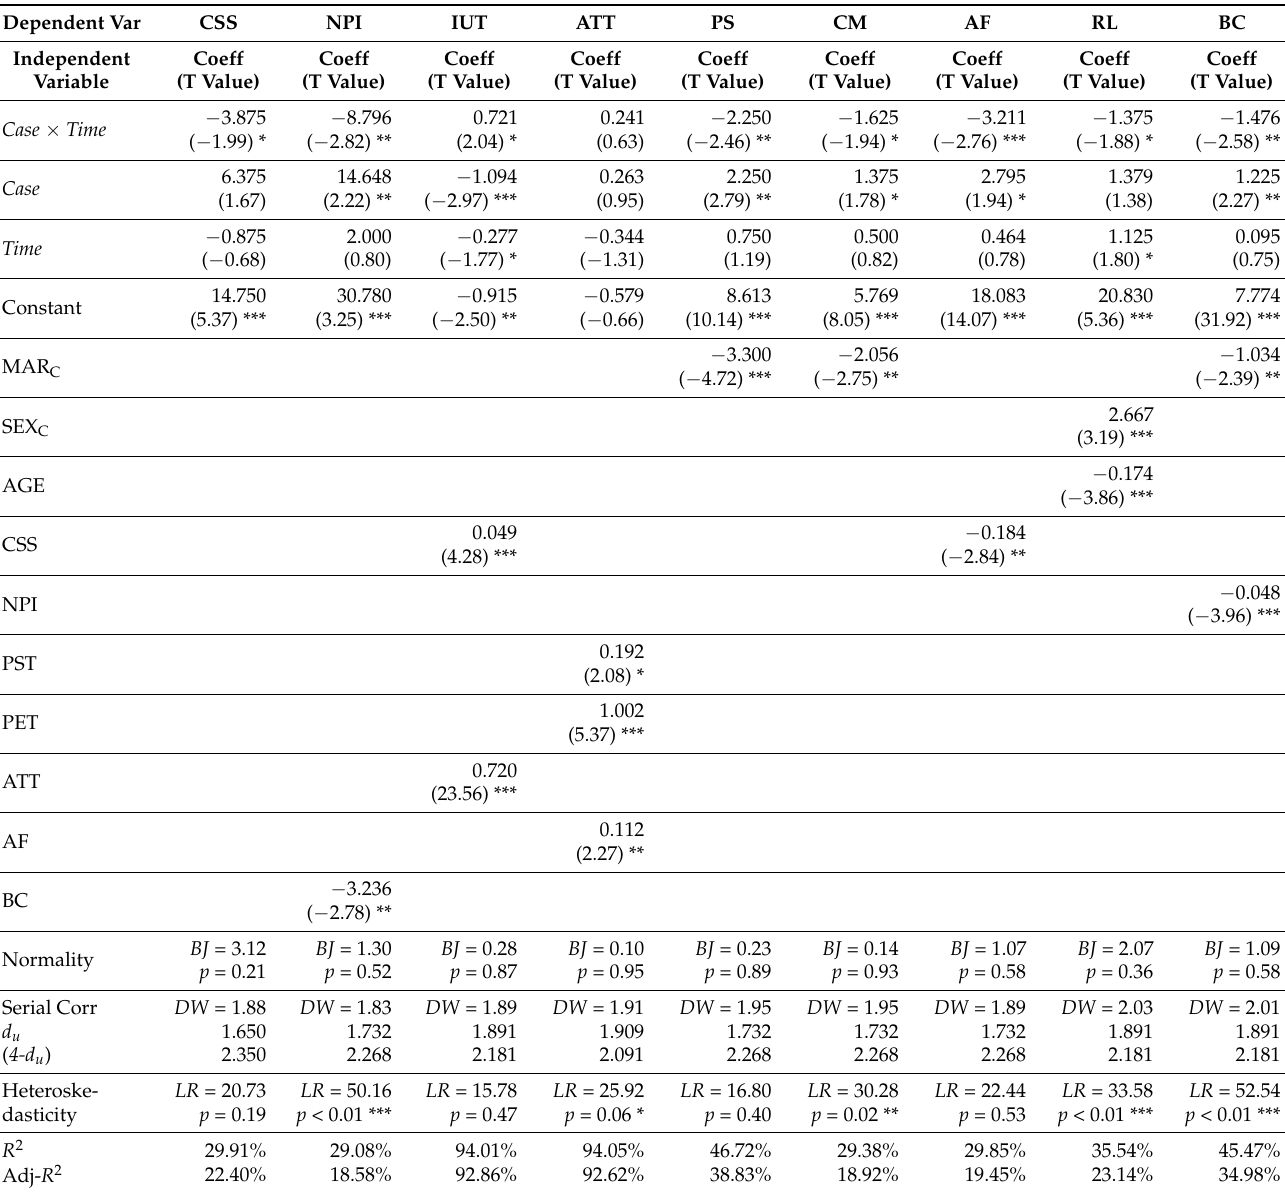
Table 5. Results for the difference-in-differences regression